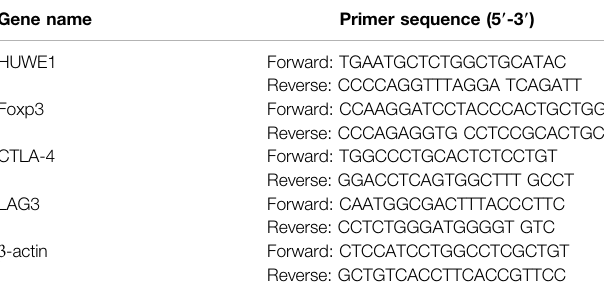
TABLE 1 | The sequences of all primers used in